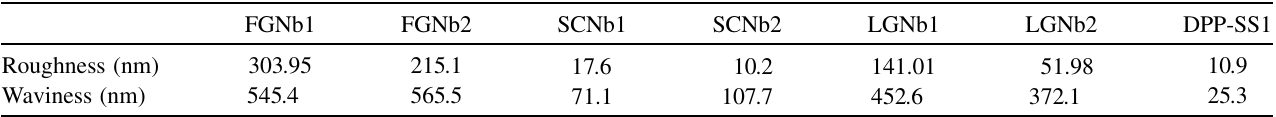
TABLE IV. Surface roughness values of all electrodes obtained using an optical profilometer.